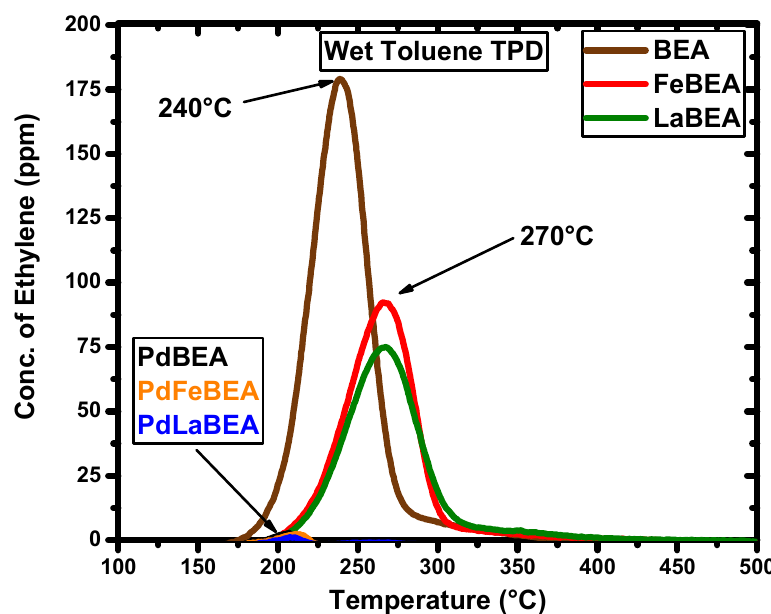
Figure 9. Temperature-programmed desorption of toluene at wet conditions where the concentration of formed ethene is plotted against the corresponding temperature for BEA, Fe / BEA, La / BEA, Pd / BEA, Pd / Fe / BEA, and Pd / La / BEA.